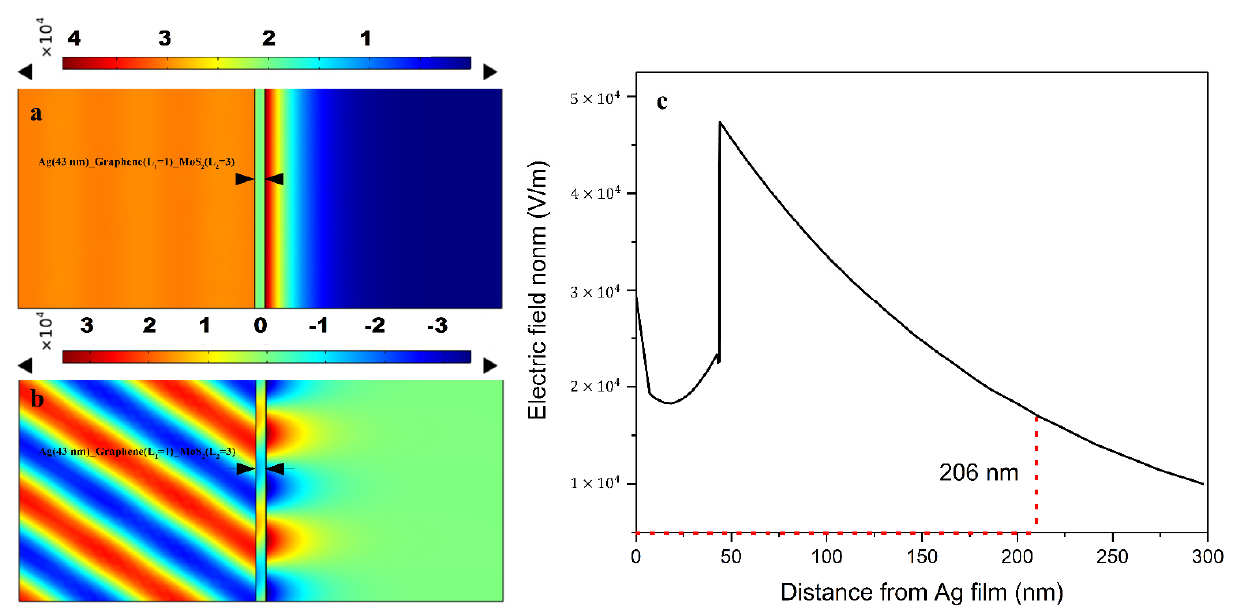
Figure 7. Electric field distribution ( a ) and y component (TM mode) ( b ) in 2D space based on a composite structure composed of single-layer graphene, three-layer MoS 2 , and 43 nm thick Ag film with SPR angle. ( c ) Evanescent decay of the excited electric field penetration into the sensing regime (the red line denotes that the electric field intensity attenuates to 1/e, ~206 nm).